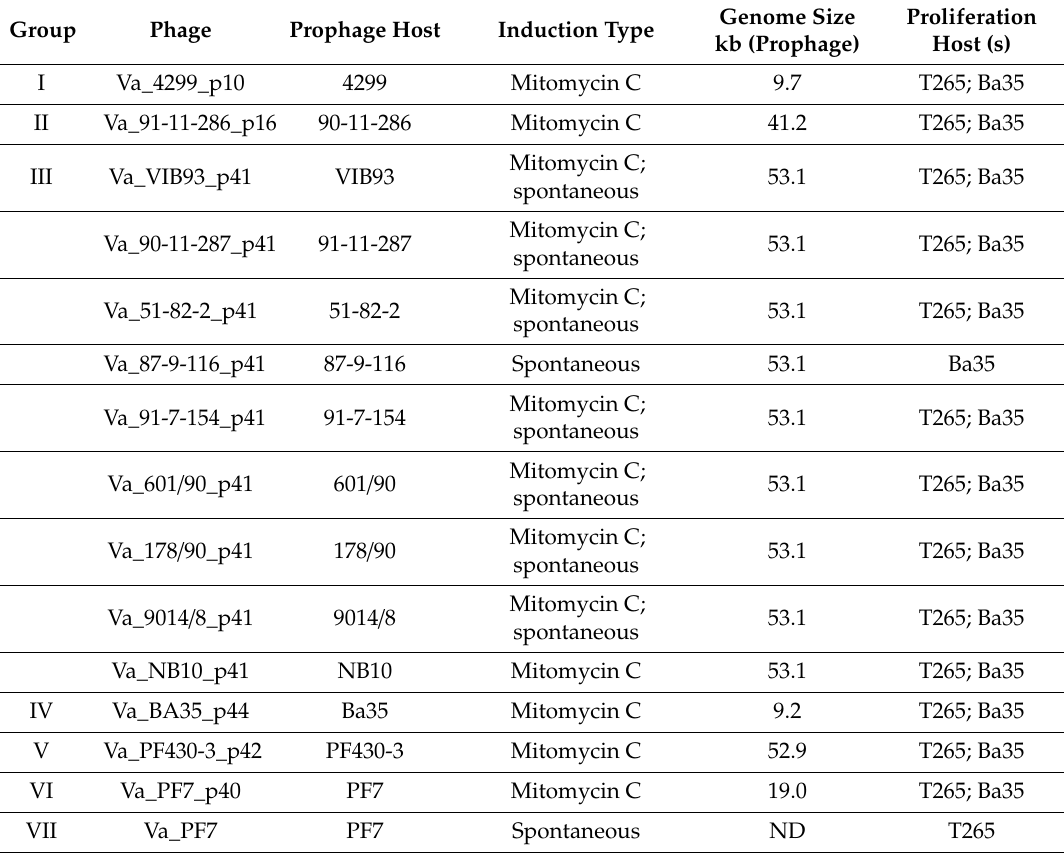
Table 1. Group of induced phages from V. anguillarum